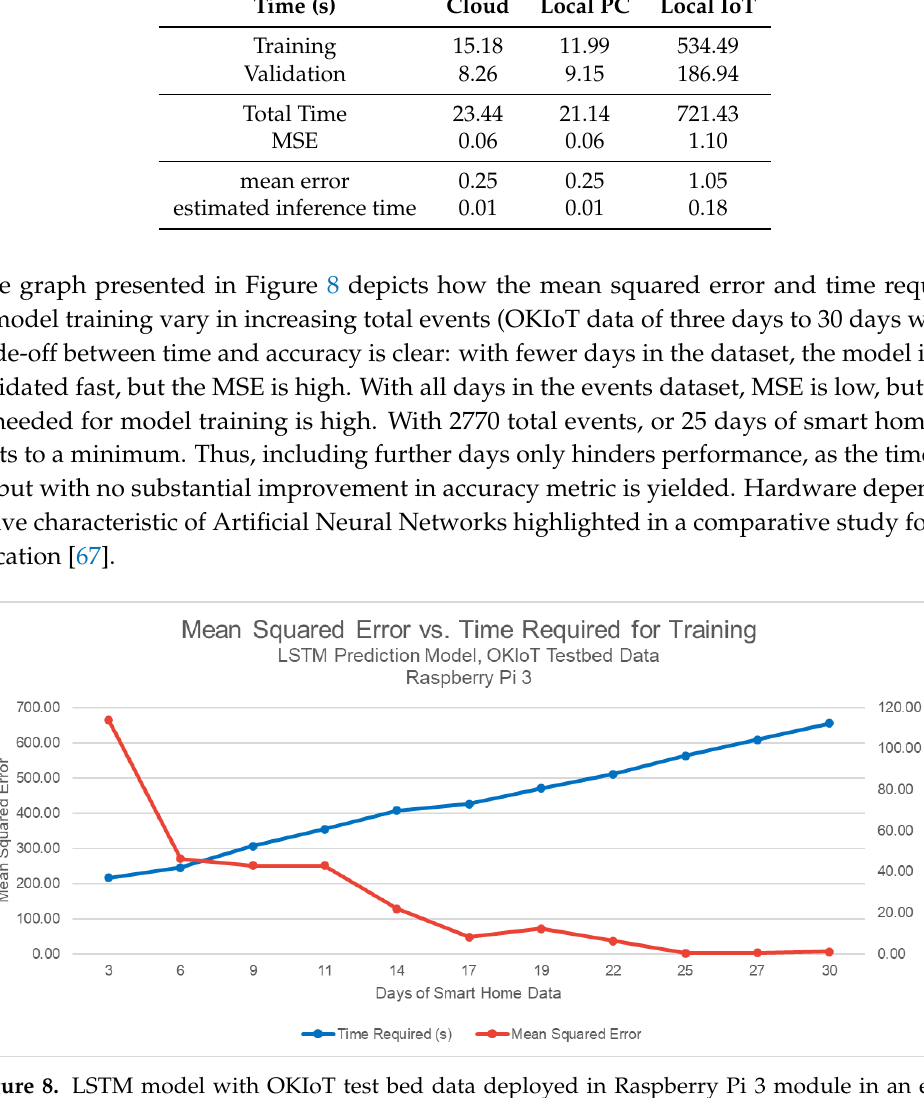
Figure 8. LSTM model with OKIoT test bed data deployed in Raspberry Pi 3 module in an edge computing